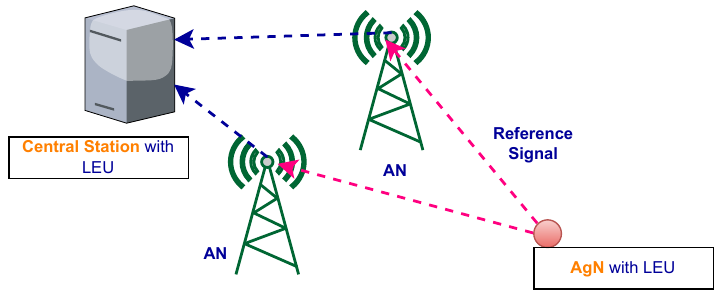
Figure 3. Remote